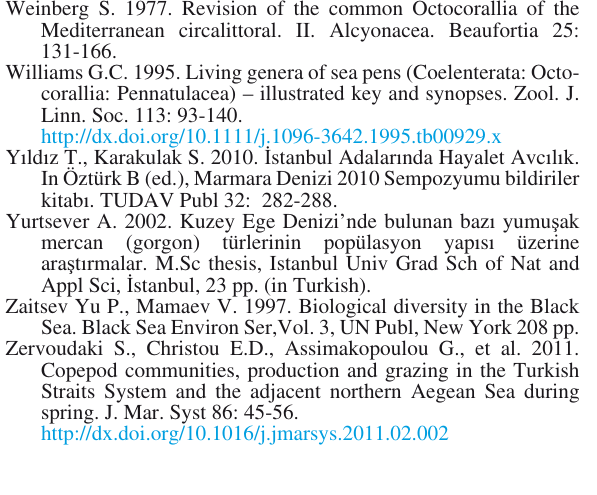
Fig. S1. – Red Alcyonium acaule colony on rocky bottom at station S1 (A); colony on bioconcretion at station S9 (B); colony on the crab Maja crispata at station S6 (C); orange colony at station S6 (D); two small colonies on a dead mussel shell at station S13 (E); surface brooder colony at station S1 on august 2013 (F) and shark egg cases attached colony at station S1 (G). Video S1. – Video taken in 1975 at Balıkçı Island by a local diver. In the video, a very dense assemblage of Savalia savaglia / P. clavata is clearly seen, revealing large